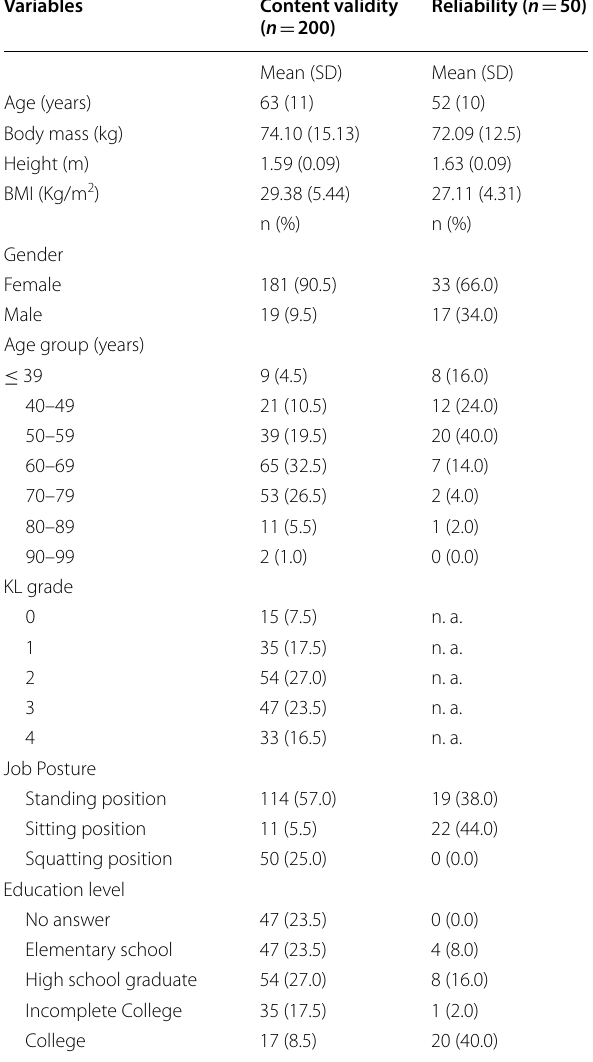
Table 1 Characteristics of samples in the phases of content validity and